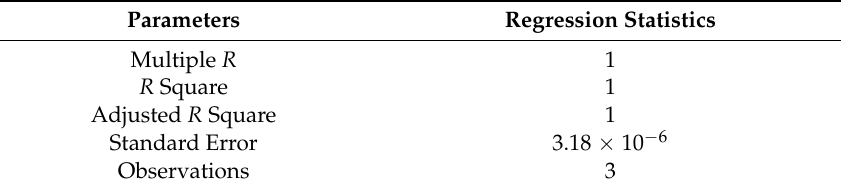
Table 12. The regression statistics of model and